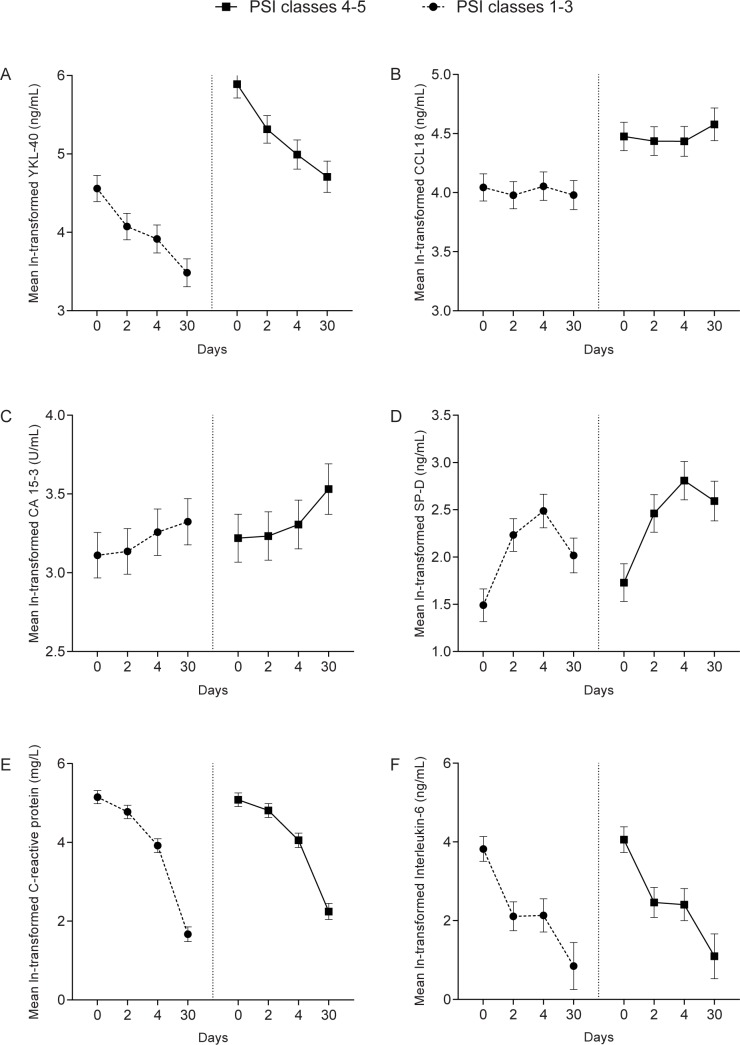
Change in log normally-transformed pulmonary marker levels over time for pneumonia severity index score.Data are shown as estimated marginal means with 95% confidence intervals.